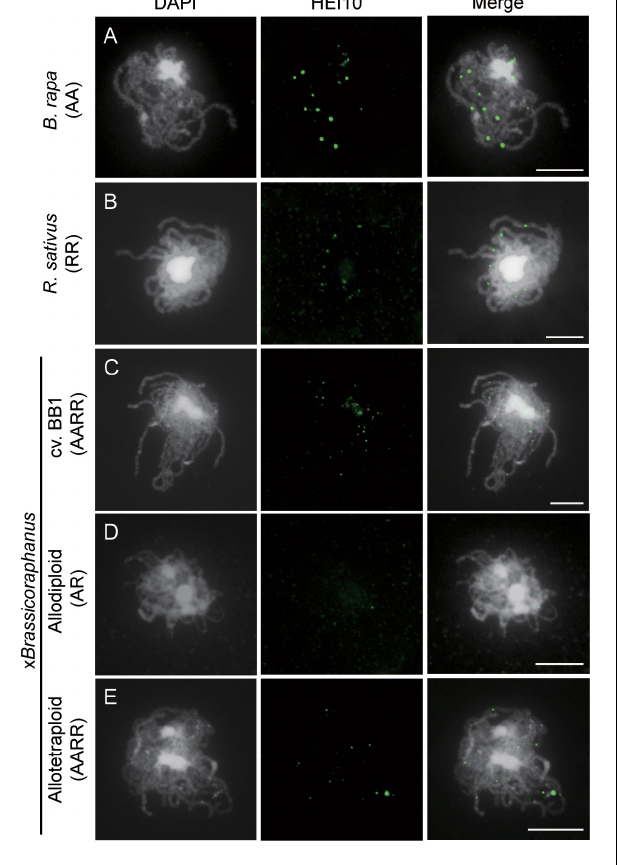
FIGURE 4 | Immunolocalization of HEI10 at pachytene. HEI10 foci were observed in PMCs of B. rapa (A) , R. sativus (B) , BB1 (C) , synthetic allodiploids (D) , and allotetraploid x Brassicoraphanus (E) . Few HEI10 foci were detected in allodiploid x Brassicoraphanus . Chromosomes were labeled with DAPI (white) and HEI10 antibodies (green). The overlay of two signals is shown (Merge). Scale bars = 10 µ m.